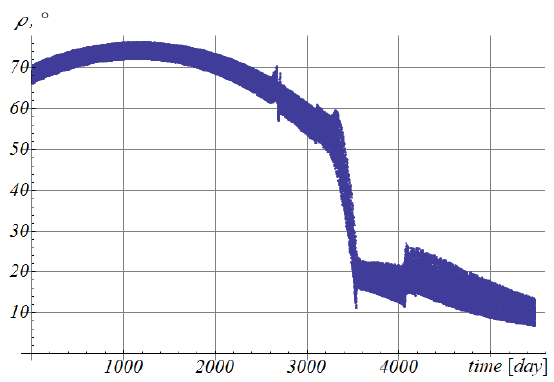
Figure 6. Evolution of angle ρ in scenario 1.